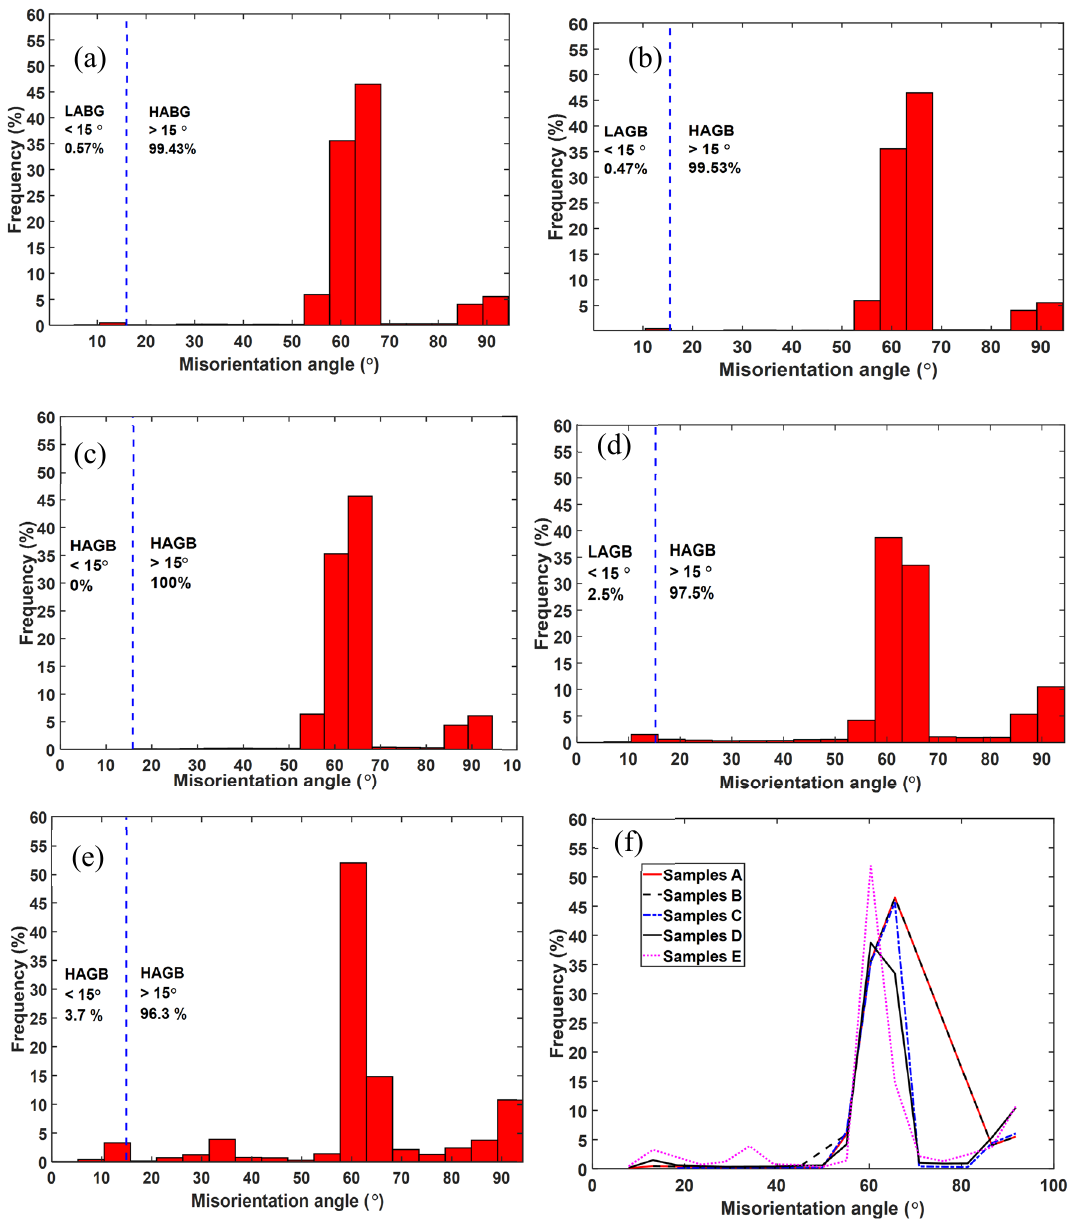
Figure 5. Distribution of grain boundary misorientation angles of the samples ( a ) A, ( b ) B, ( c ) C, ( d ) D, ( e ) E and ( f ) line graph plot for comparison.